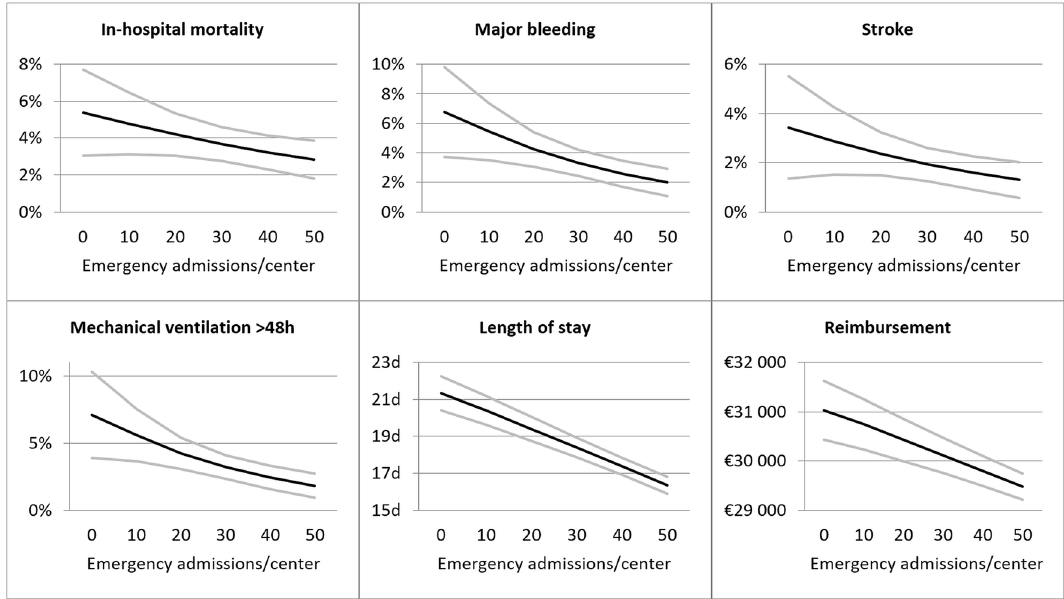
Figure 3. Continuous impact of TAVI procedure volumes with emergency admission in Germany in 2018. Presentation of significant factors. Predicted outcome (black line) and 95% confidence intervals (grey lines), divided up according to the number of TAVI cases with emergency admission treated per hospital and year. For the complete data see Supplementary Table